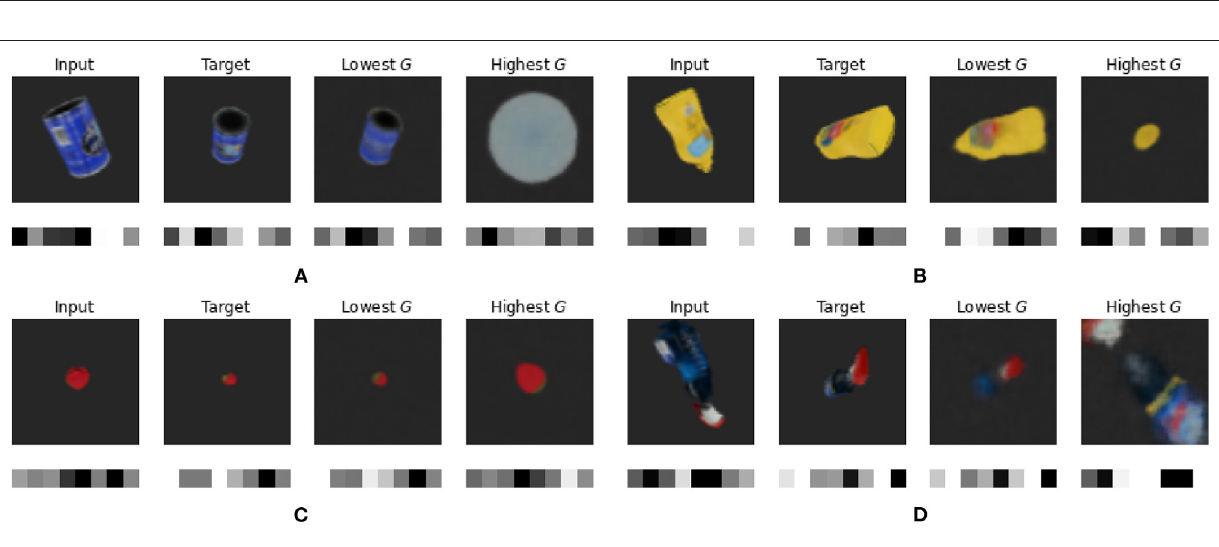
FIGURE 7 | Qualitative results for object pose estimation for (A) master chef can, (B) mustard bottle, (C) strawberry, and (D) windex bottle. The first column shows the input of the model with the mean latent code shown below. The second column shows the target observation along with its mean latent code. The third column shows the imagined observation and the transitioned latent code for the action with the lowest expected free energy G , while the final column shows the imagined observation and latent code for the action with the highest expected free energy G